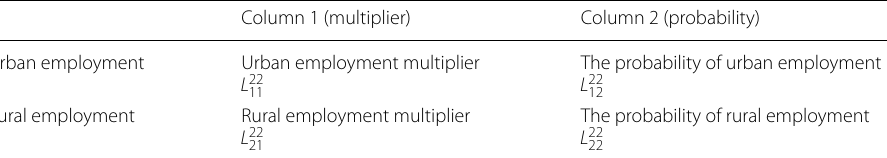
Table 2 Interpretation of urban and rural labor allocation multiplier ( L 22